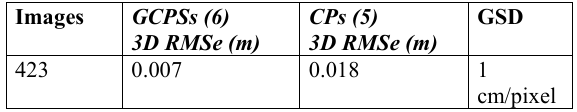
Table 3. Zenmuse P1 main processing results